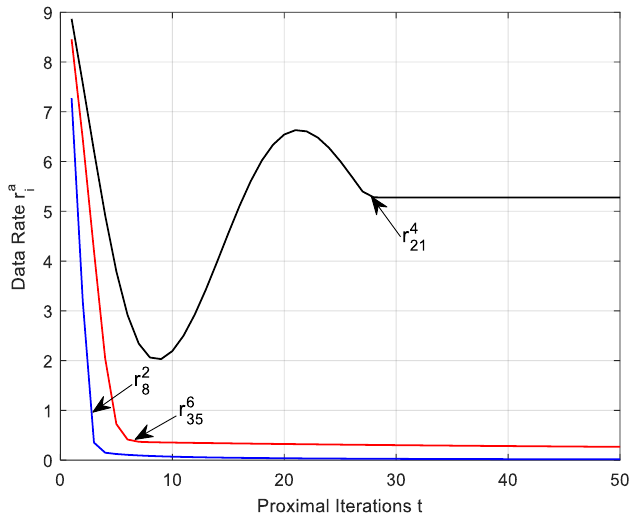
Figure 6. Convergence of data rates versus proximal t .